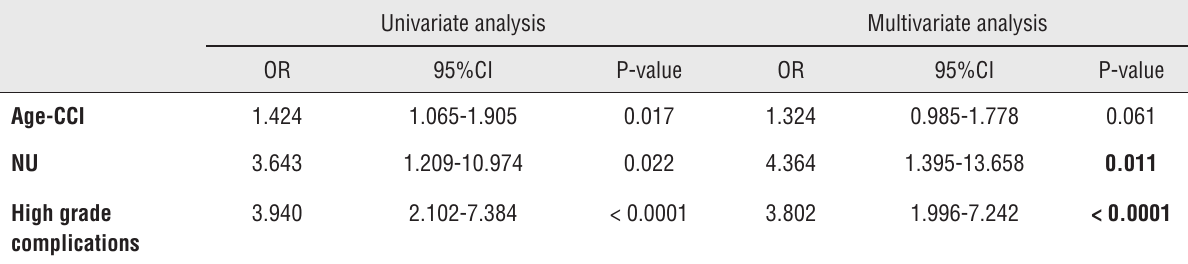
Table 4 – Univariate and Multivariate Analyses for factors predicting Acute Kidney Injury after Radical cystectomy. Univariate